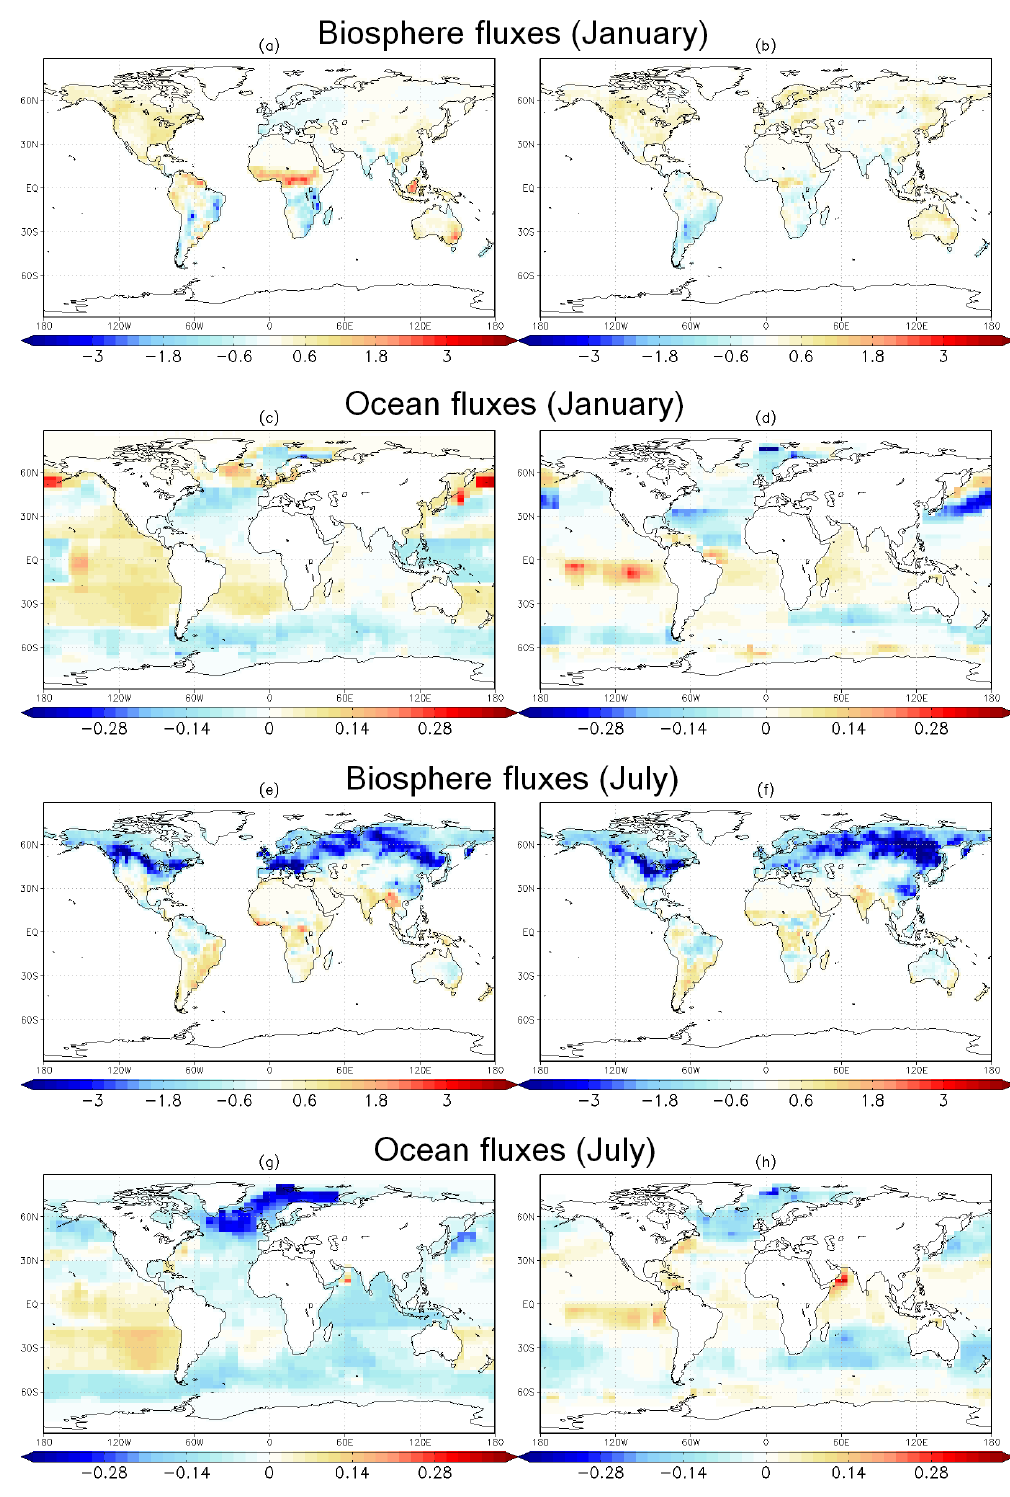
Fig. 5. Mean annual fluxes for biosphere and ocean in units gm − 2 day − 1 . Column 1 represents results for region approach, column 2 represents results for EOF